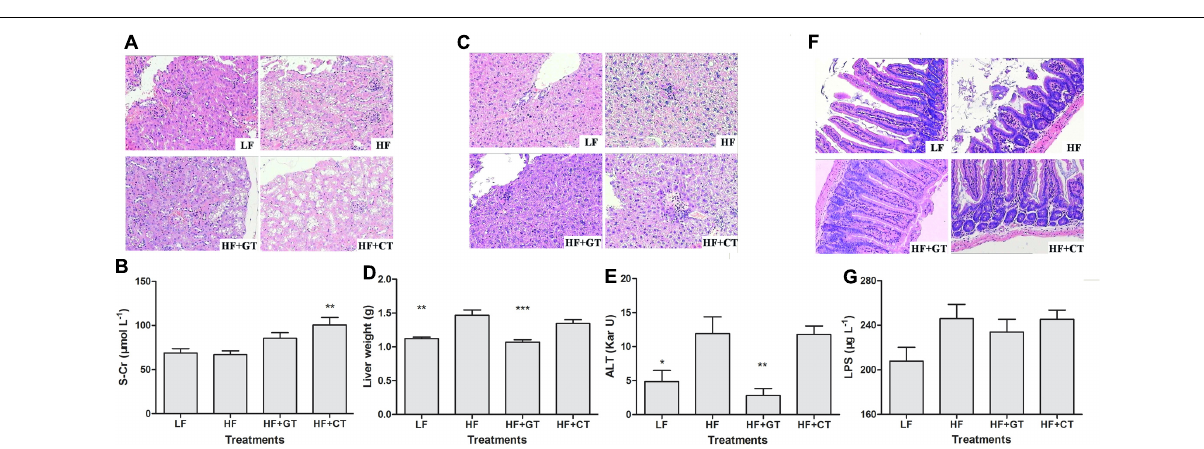
FIGURE 3 | Morphological and functional changes of kidney, liver, and small intestine in C57BL/6J mice. Kidney tissues (A) , Liver (C) , and small intestine (F) by HE staining. S-Cr (B) , liver weight (D) , ALT (E) , and LPS (G) values in different groups. Data were compared with HF group. Mean ± SEM. ∗ P < 0.05; ∗∗ P < 0.01; ∗∗∗ P <